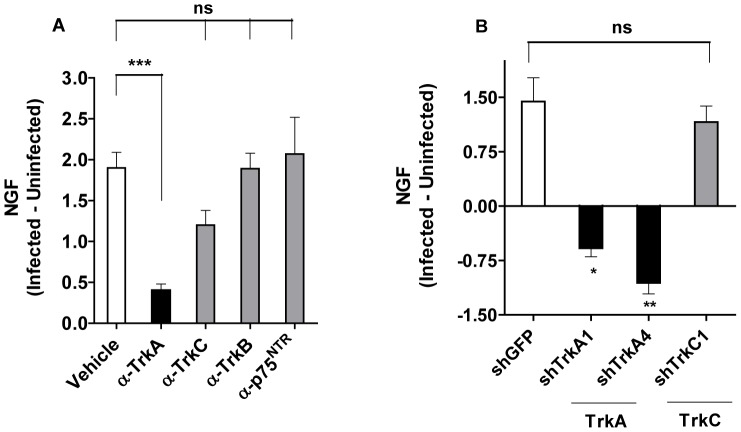
TrkA is targeted by T cruzi for upregulation of NGF in cardiac fibroblasts.
A) Antibodies against TrkA, but not against TrkB, TrkC or pan-neurotrophin receptor p75 (p75NTR) significantly abrogate T cruzi-induced upregulation of NGF on cardiac fibroblasts. Primary cardiac fibroblasts were preincubated with the indicated antibodies (1 µg/ml), infected with T cruzi for 24 h, and the concentration of NGF in the culture overlays determined by ELISA. The results are the mean ± sd of triplicate points and represent the difference between NGF secreted by infected and uninfected cardiac fibroblasts; ***, P<0.001.B) shRNA against TrkA abrogates T cruzi-induced upregulation of NGF on cardiac fibroblasts. Cardiac fibroblasts were transfected with lentivirus encoding shRNA constructs against GFP, TrkA (two distinct vectors), or TrkC (one vector). Seven days later, fibroblasts were infected with T cruzi for 24 h, and NGF content in the culture overlays determined by ELISA. Results are the mean ± SEM of five separate experiments with similar results, and represent the difference between NGF secreted by infected and uninfected cardiac fibroblasts; *, P<0.05, **, P<0.005.